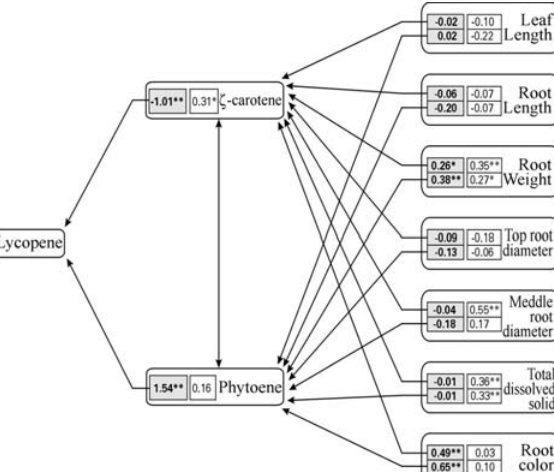
Figure 1 - Causal diagrams reflect the interrelationships between lyco- peneandtheprimaryexplanatoryvariables( ζ -caroteneandphytoene)and the secondary explanatory variables (leaf length, root length, root weight, topandmiddlerootdiameter,totaldissolvedsolidsandrootcolor)fortwo F 2 carrot populations (B493 x QALand Brasilia x HCM).The path coeffi- cient( $ p )forcellswithablackbackgroundarefortheB493xQALpopula - tion while a white background shows the values for the Brasilia x HCM population. *significant by the t-test (n-2 degrees of freedom) at 1%. ** significant by the t-test (n-2 degrees of freedom) at